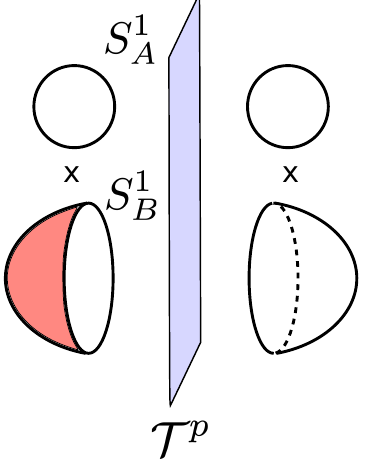
Figure 6 . Heegaard decomposition of L ( p; 1), where the two solid tori are glued with a T p trans- formation. In red is shown the 2 cycle with Z N coe(cid:14)cients. For this to be consistently extend to the right side, we must have p = 0 mod N , which re(cid:13)ects the fact that the homology group is non-trivial only in this